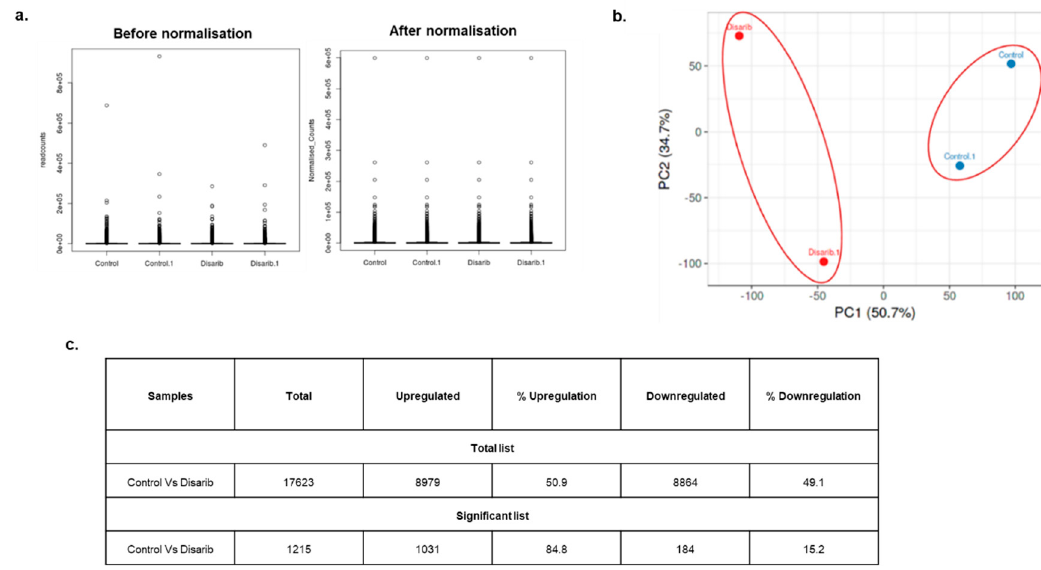
Figure 2. Preliminary analysis of EAC Control and treated samples. ( a ) Quantile normalised plots for EAC control and Disarib treated samples before and after normalisation. ( b ) Principal component analysis of EAC control and treated samples. Blue dots represent control, and red dots represent Disarib treated samples. ( c ) Table depicting the number of up and downregulated genes upon Disarib treatment in EAC tumour samples.